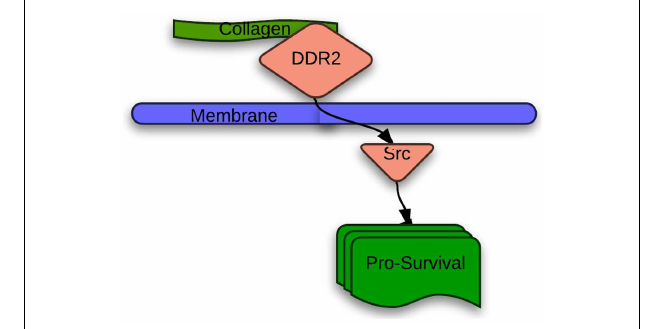
FIGURE 1 | Proposed DDR2 signaling in lung cancer